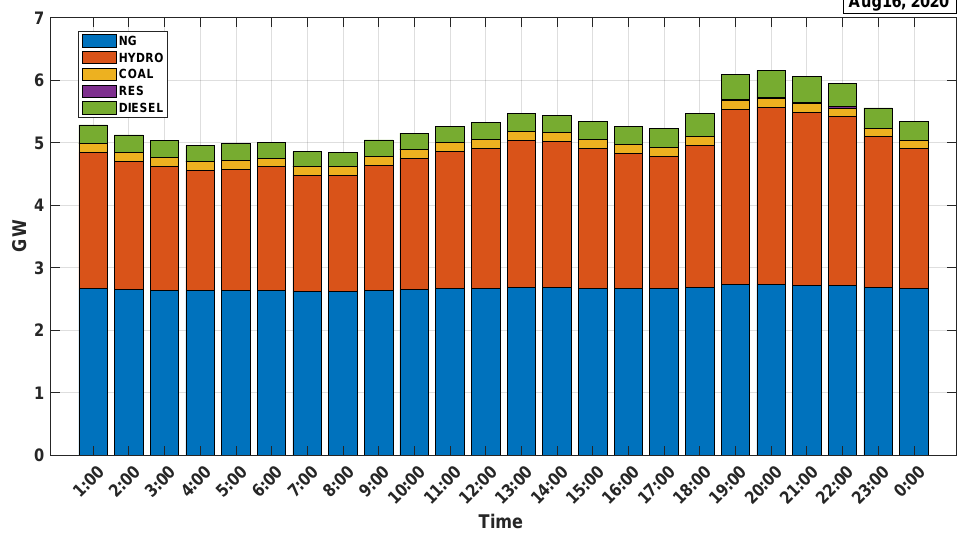
Figure 16. Contribution added to the dispatch by type of technology—stage